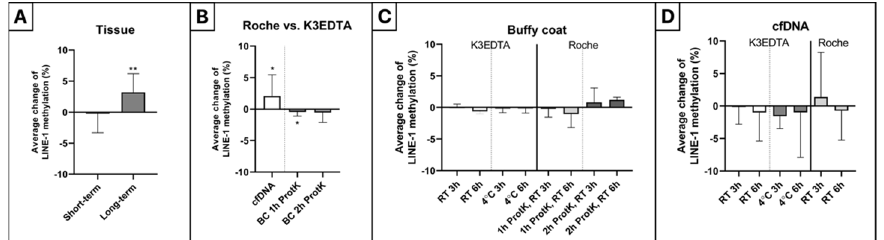
Figure 3. Impact of different storage conditions on LINE-1 methylation. ( A ) In the case of short-term storage, − 0.9% methylation alteration was observed, while significantly elevated LINE-1 methylation values (+3.2%) were detected following long-term − 20 ◦ C storage of the isolated DNA (** p ≤ 0.01). ( B ) Significant LINE-1 methylation increase and decline were observed in cfDNA (+2.1%) and 1 h ProtK buffy coat ( − 0.4%) samples in comparison with standard K3EDTA tubes (* p ≤ 0.05), respectively. A non-significant, slight decrease was found in 2 h ProtK buffy coat specimens ( −